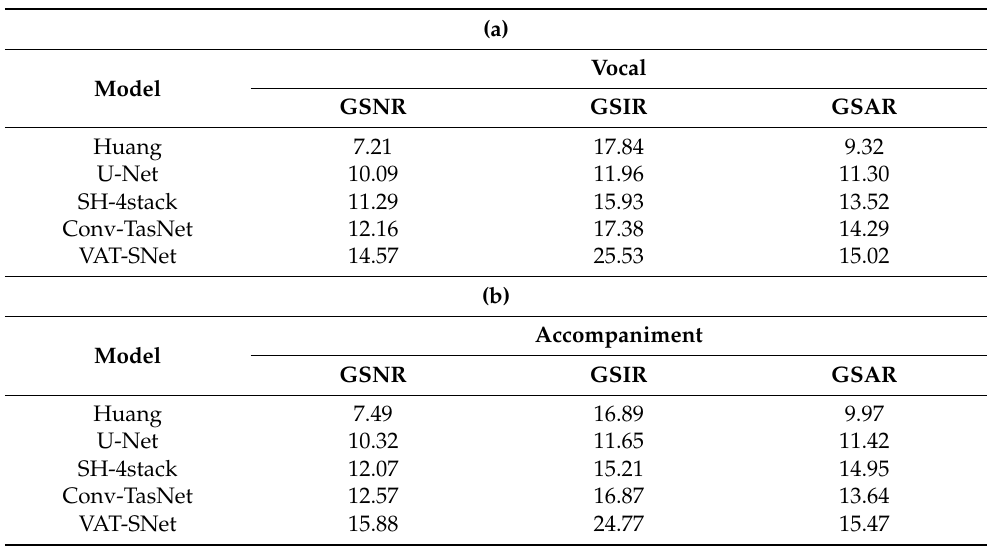
Table 4. Comparison of separation performance of 200 music clips in MIR-1K (average